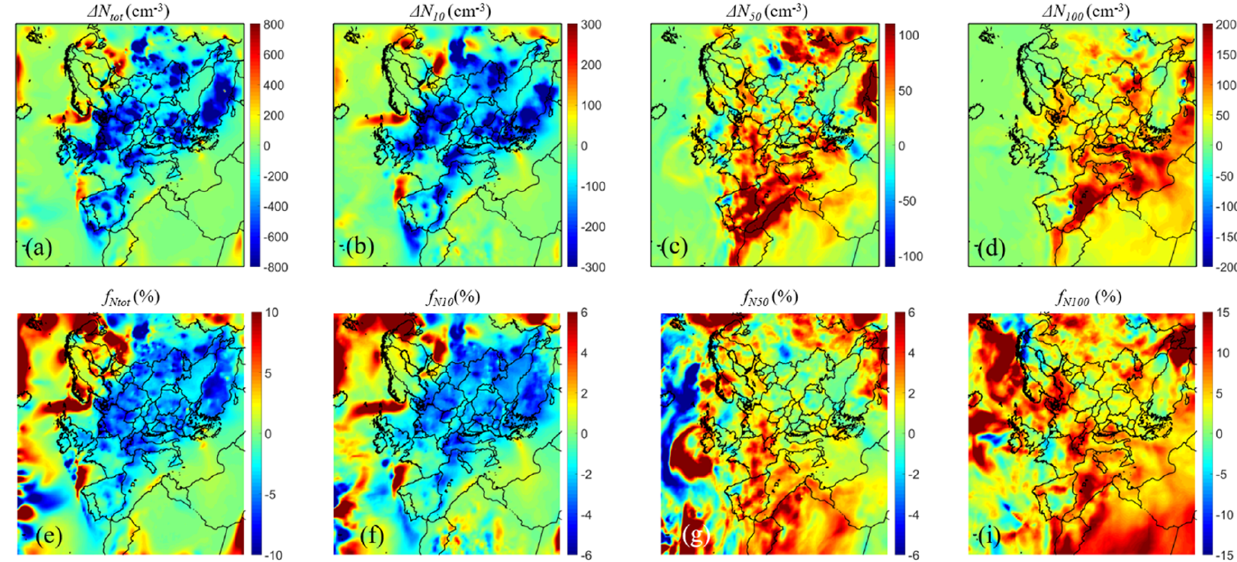
) in number concentration (e–i) due x